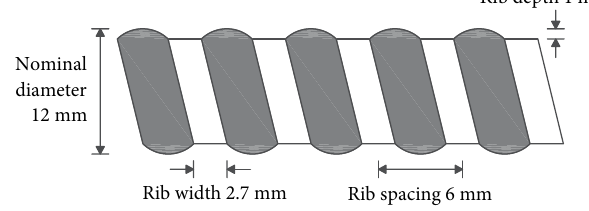
Figure 1: Geometric shape of the BFRP